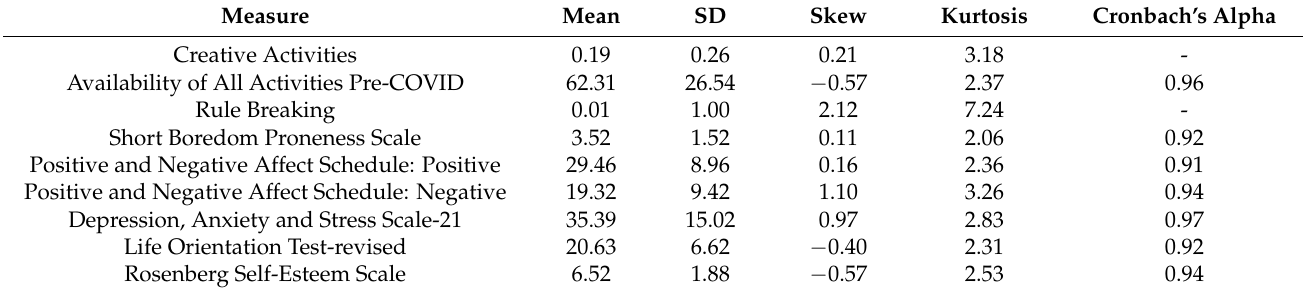
Table 1. Descriptive statistics.